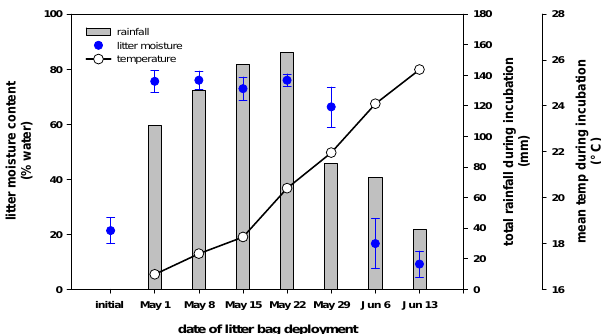
Fig. 1. Moisture content of organic matter contained in litter bags (blue circles) after 4 weeks of incubation ( n = 5, error bars represent one SD), mean daily air temperature (open circles), and total rainfall during each 4-week incubation (vertical bar). Dates on the X-axis indicate the beginning of each incubation period; the label “initial” on the X-axis indicates the mean ( ± SD) initial moisture content of litter placed in bags at the beginning of each experiment. Daily air temperature and precipitation data are from the Melfa Accomack Co. Airport climate station (NOAA National Climatic Data Center station KMFV) located in Melfa, VA, approximately 25km from our Phillips Creek study